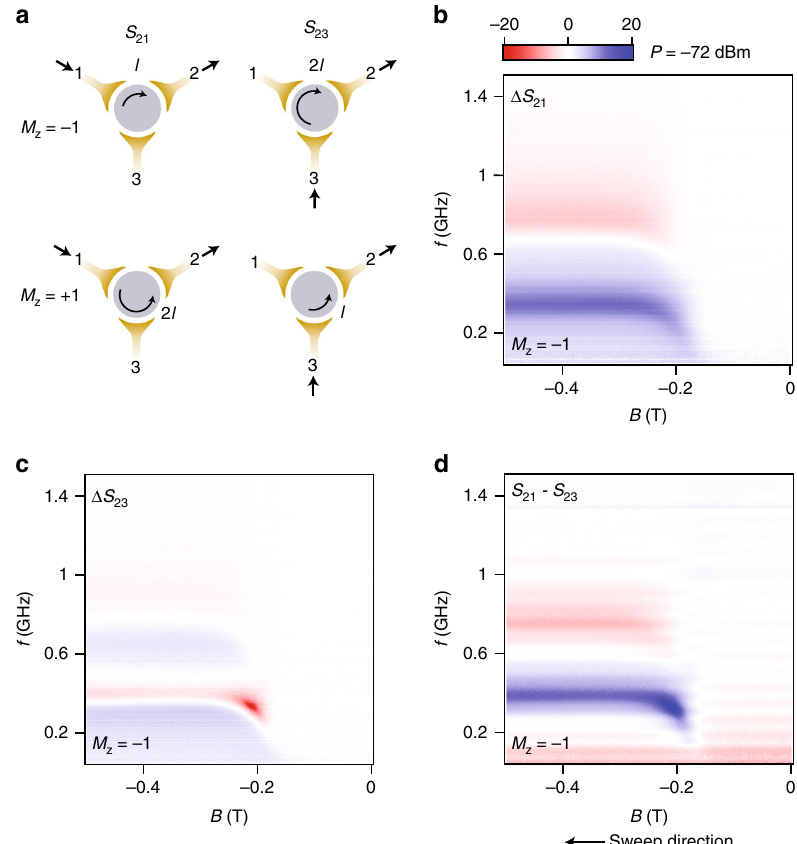
Fig. 2 Microwave transmission measurement. a Illustration of chiral edge transport in a circulator setup for different magnetisation and port con fi gurations. Arc path lengths are denoted as l and 2 l . b , c show the microwave response of signals excited from ports 1 and 3, and ampli fi ed out of port 2, as the magnetic fi eld is varied. These traces have been normalised to the reciprocal background prior to sample magnetisation, such that the colour bar represents Δ S in dB. In d , the colour bar shows S 21 − S 23 in dB, where the difference between the bare S-parameter traces is plotted without background normalisation. Past the coercive fi eld of − 0.16 T, strong non-reciprocity is observed at two distinct frequency bands, with opposite